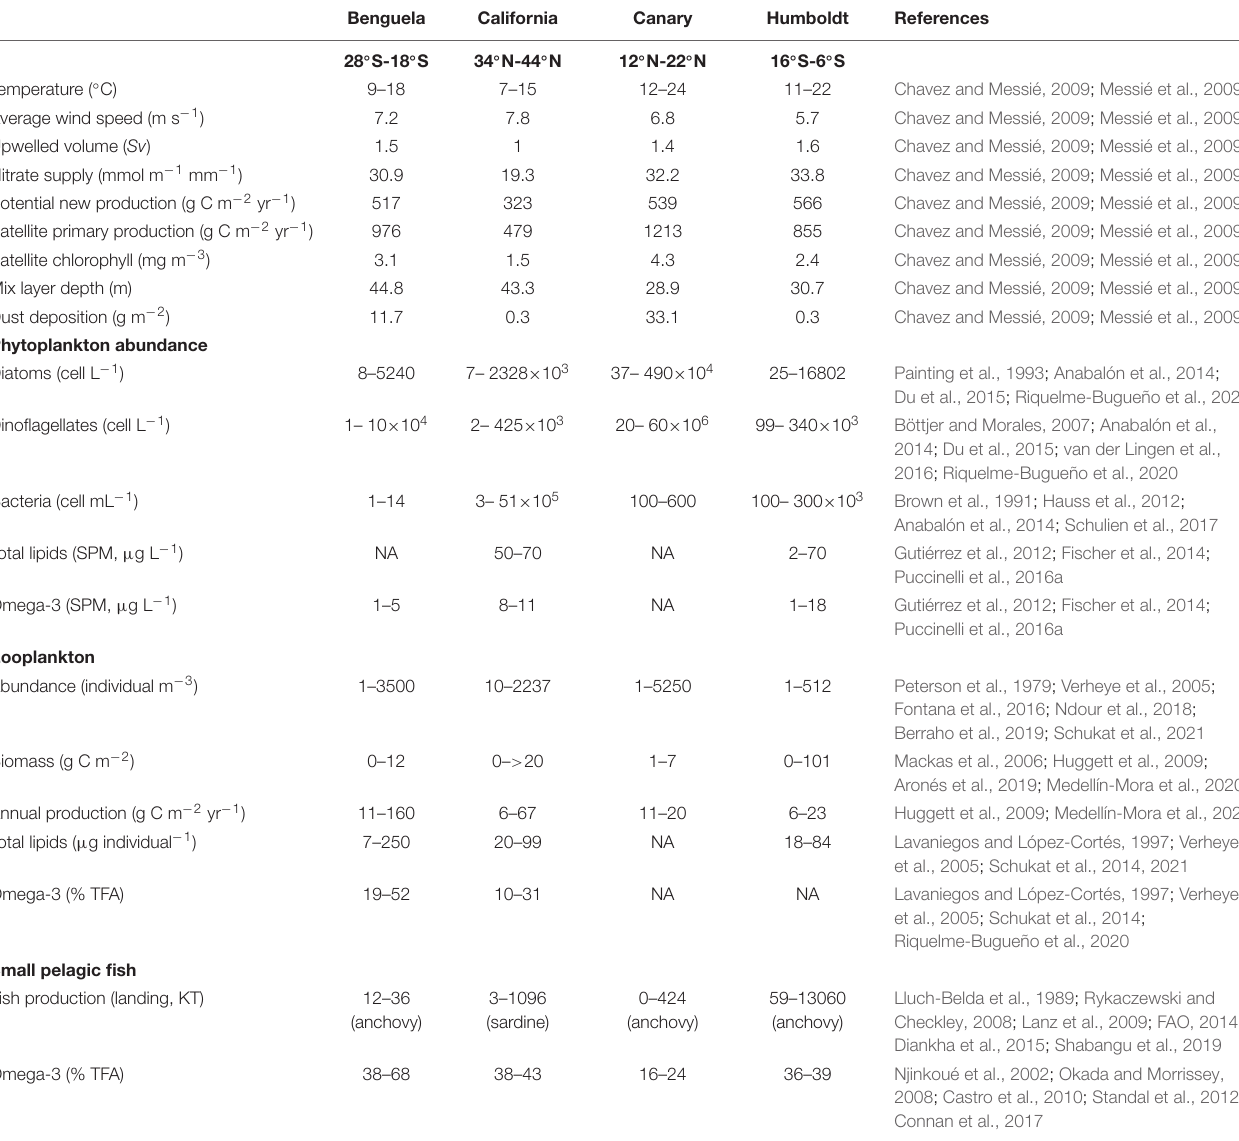
TABLE 1 | Comparison of selected abiotic and biotic parameters in the four Eastern Boundary Upwelling Systems (Benguela, California, Canary, Humboldt) based on published literature. Benguela